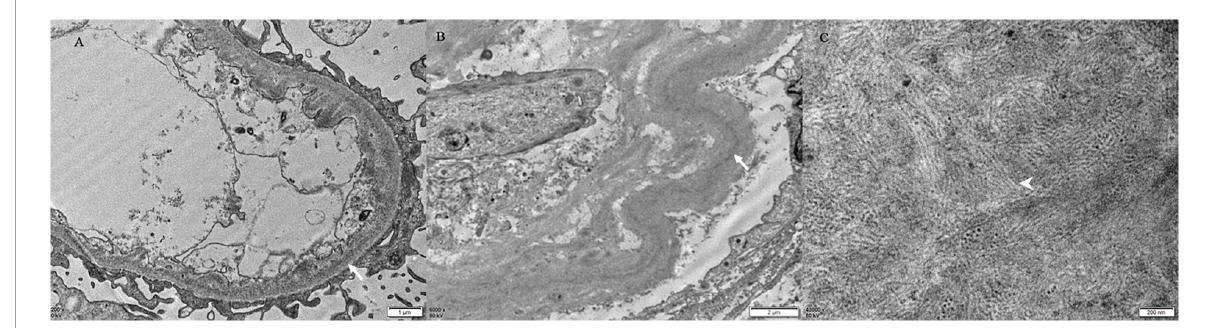
FIGURE3 Electron microscopy findings. There are finely punctate “powdery” electron-dense deposits (white arrow) involving the inner aspect of the GBM (A) and the outer aspect of the TBM [white arrow, (B) ] [Patient 4, (A) × 200, (B) × 6,000]. (C) The mesangial deposits comprised microtubular substructures (diameters of 20–50 nm) with hollow cores (arrowhead) arranged at least focally in parallel arrays (Patient 4 × 43,000).